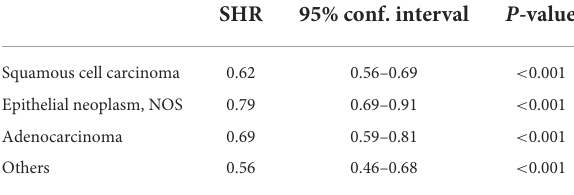
TABLE 5 Sub-distribution hazard ratio of developing second primaries after a bladder cancer diagnosis among the different histological variants; transitional carcinomas are the